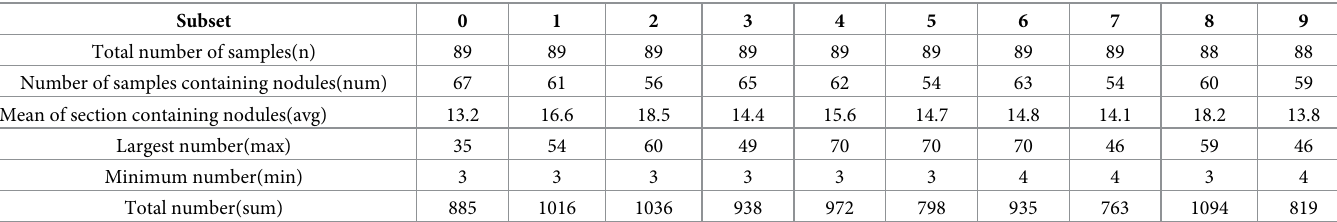
Table 2. The number of each subset and sections of pulmonary nodules in subset.